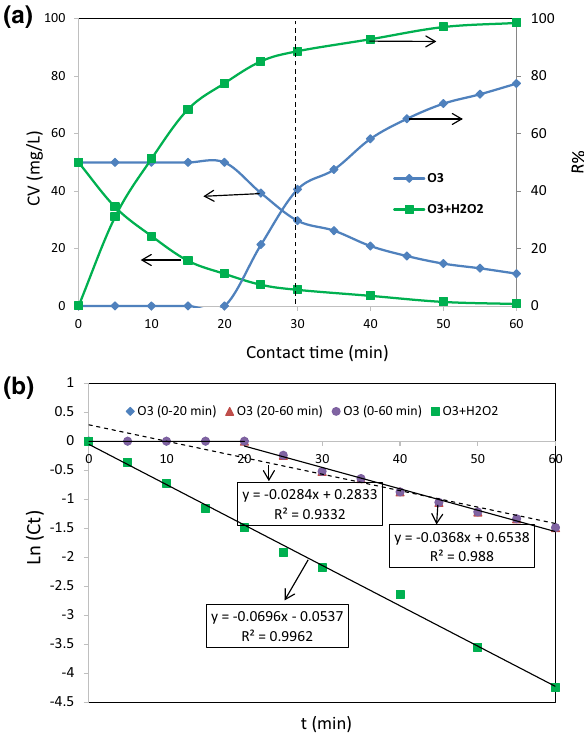
Fig. 1 Effect of OZ and PO on CV decolorization a first-order kinetic evaluation b [condition: reactor volume 500 cc and 70 rpm, unad- justed pH, initial CV concentration 50 mg/L, ozone 2 mg/L. min, and H 2 O 2 15